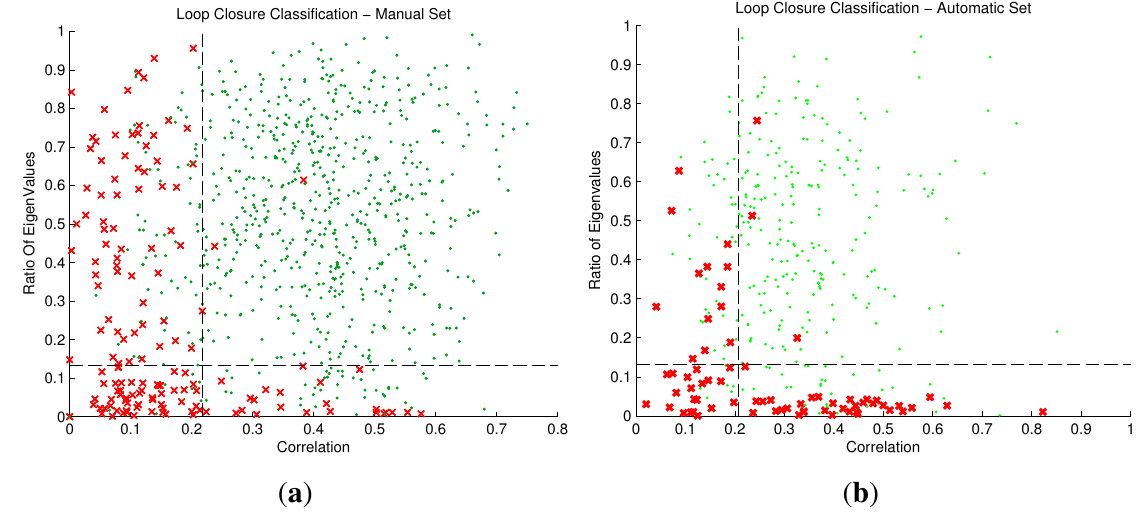
proposed metrics. A red × corresponds to a failed loop closure transformation, while a green ◦ represents a successful candidate pair. The chosen thresholds are denoted using the dashed black lines. ( a ) The results for the manually defined loop closure candidates. ( b ) The results for the automatically detect set of loop